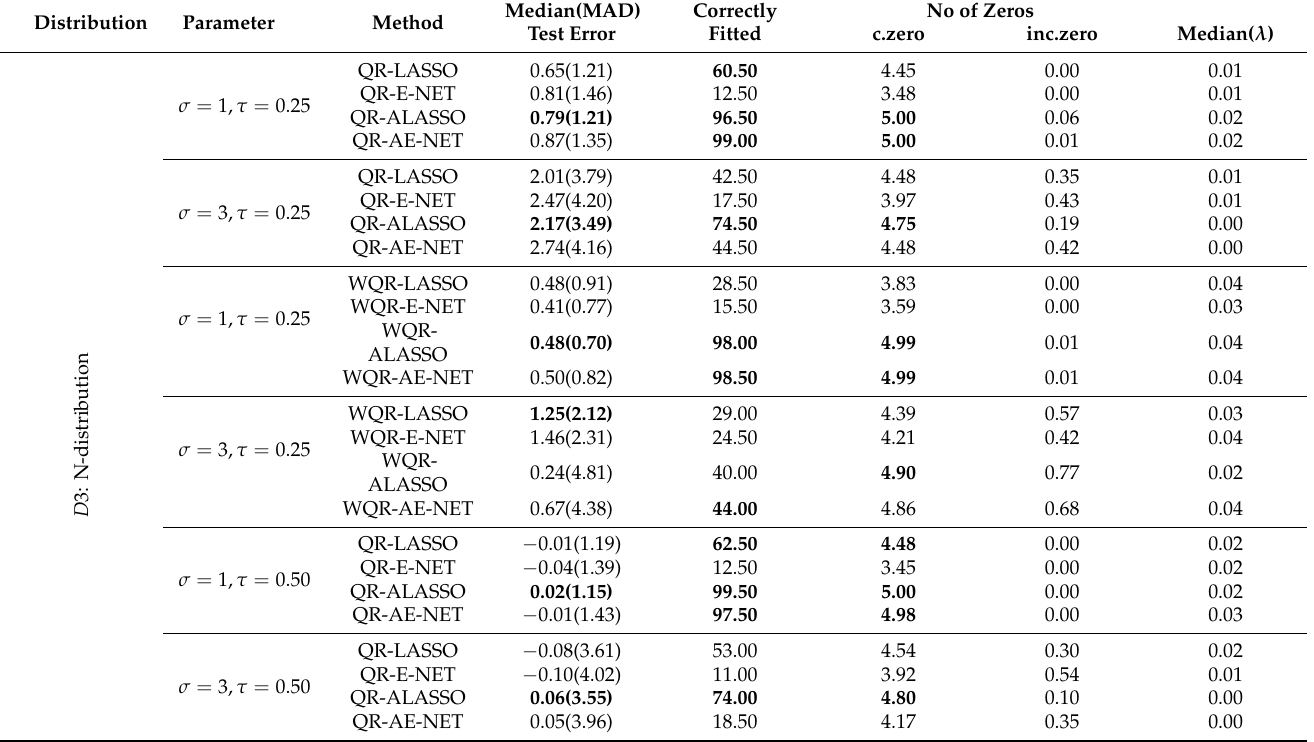
Table 3. Penalized weighted and unweighted quantile regression at D 3 and D 5 for n = 50 ( τ = 0.25 and τ = 0.50) under the normal distribution; bold text indicate superior